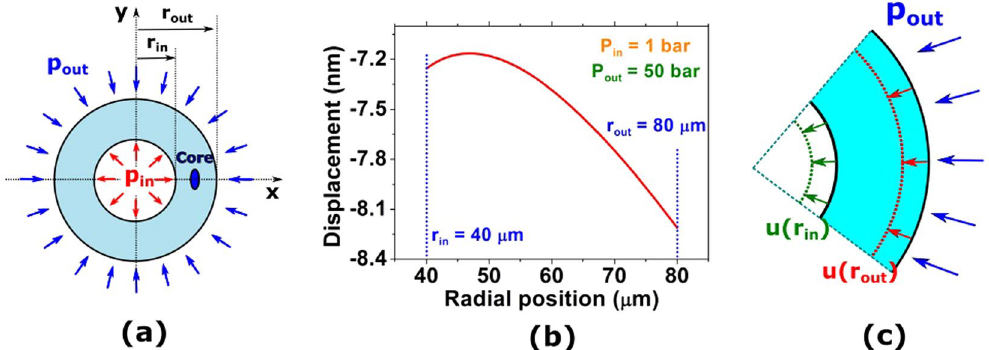
Figure 1. Capillary fibre under pressure. ( a ) Diagram of the pressurized capillary fibre with an embedded core. ( b ) Displacement as a function of the radial position for a capillary fibre with r in = 40 μ m and r out = 80 μ m under an external pressure of 50 bar and internal pressure level of 1 bar. ( c ) Schematic of the observed displacement at the inner and outer radii due to the application of